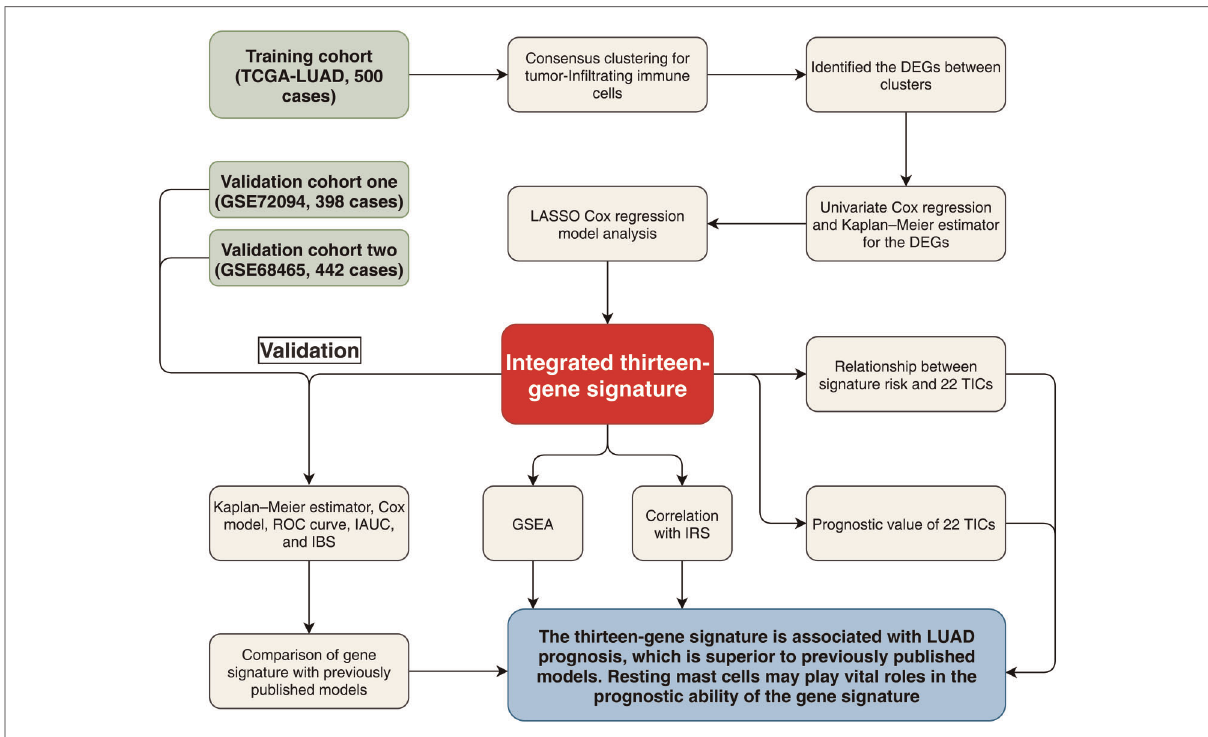
FIGURE 1 Research fl ow chart. TCGA, The Cancer Genome Atlas; LUAD, lung adenocarcinoma; LASSO, least absolute shrinkage and selection operator Cox regression model; DEGs, differentially expressed genes; ROC, receiver operating characteristic; AUC, Area under the ROC curve; IBS, integrated Brier score; IAUC, integrated AUC; IRS, immune relevant signature; GSEA, Gene Set Enrichment Analysis; TICs, tumor-in fi ltrating immune